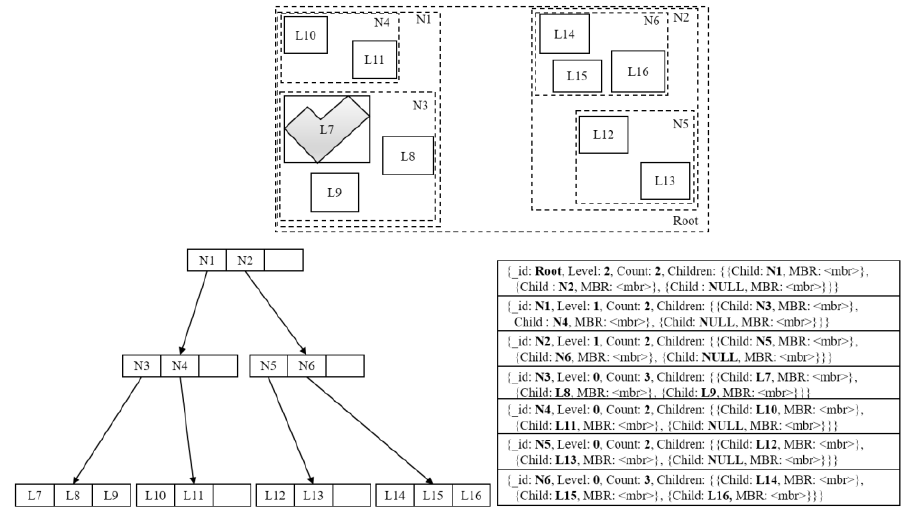
Figure 1. Flattening an R-tree into a MongoDB collection of documents.